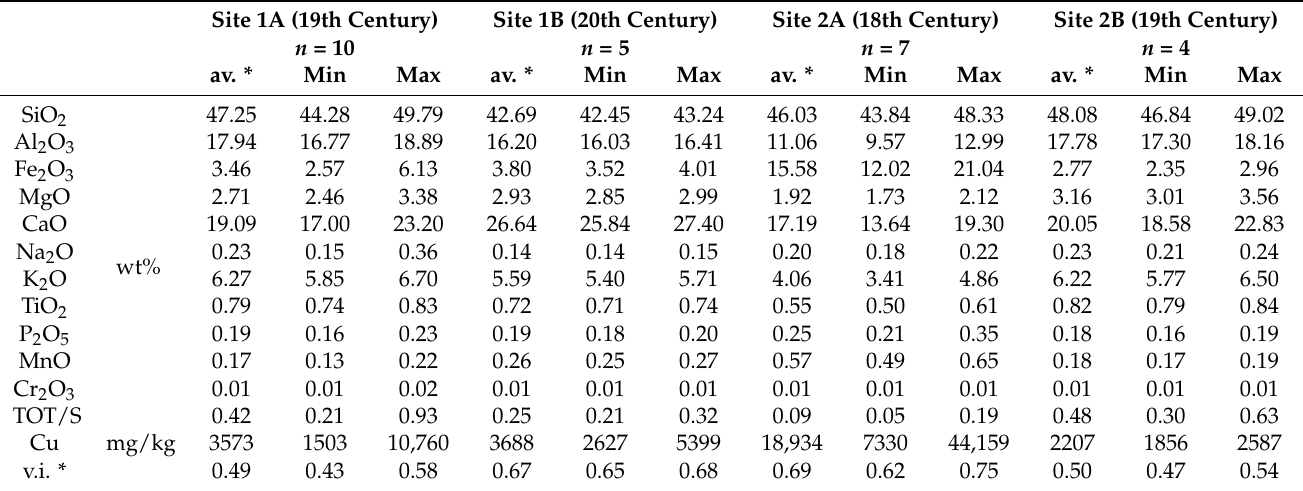
Table 2. Slags bulk chemical